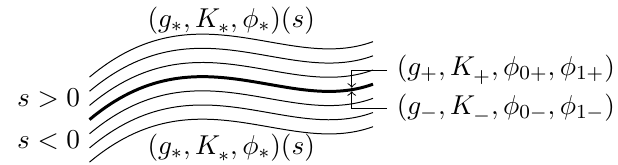
Figure 2 . Spacetime foliation by spacelike hypersurfaces H s . A singularity hypersurface H 0 along which past and future singularity data ( g ± , K ± , φ 0 ± , φ 1 ± ) are prescribed. These data specify asymptotic profiles ( g ∗ , K , φ ∗ )( s ) that solve (3.5) for s < 0 and s > 0 , with explicit expressions ∗ given in (3.9) and (3.10),